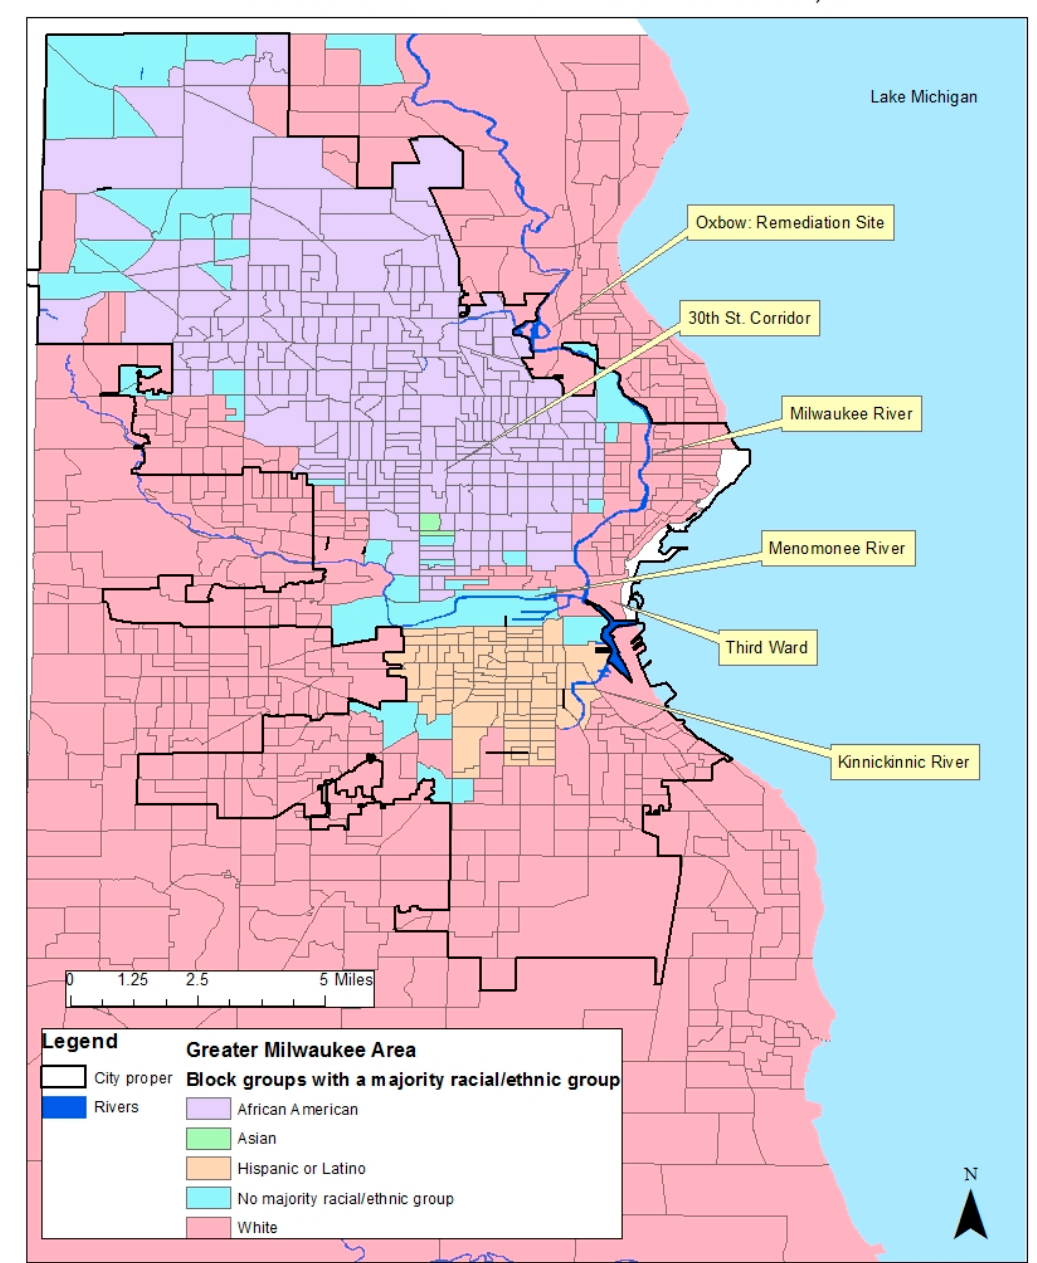
Figure 1. Shows the racial and ethnic makeup by census block group. To be considered a majority, over 50% of the population must be represented by one racial/ethnic